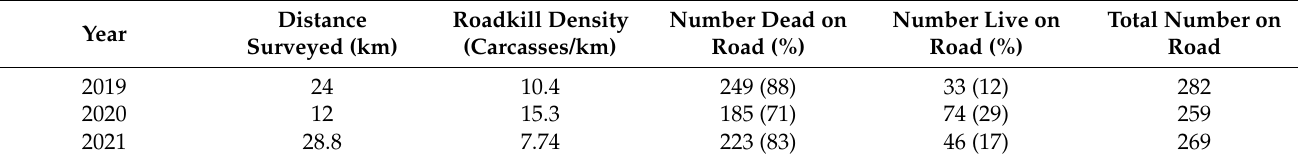
Table 2. Results of pre-pandemic (2019), pandemic season 2020, and pandemic season 2021 surveys of road mortality in Rhode